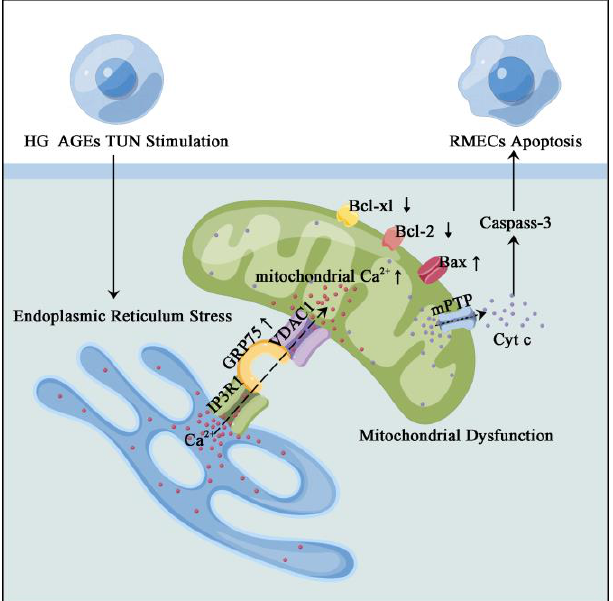
Figure 8. Possible mechanism of ER – mitochondria coupling and Ca 2+ -dependent endothelial cell apoptosis in DR. DR promotes ER – mitochondria coupling via the IP3R1 – GRP75 – VDAC1 axis and facilitates Ca 2+ transport from the ER to the mitochondria, leading to mitochondrial dysfunction and RMECs apoptosis. Inhibited ER – mitochondrial coupling, including inhibition of GRP75 or Ca 2+ overload, may be used as a potential therapeutic target for DR.